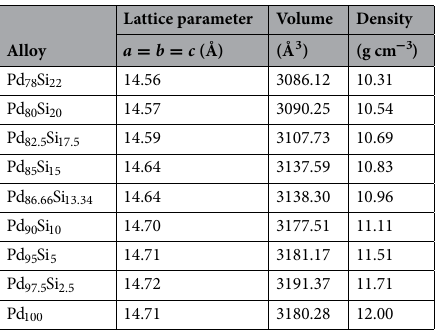
Table 1. Lattice parameters, volumes and densities of the supercells used for the various